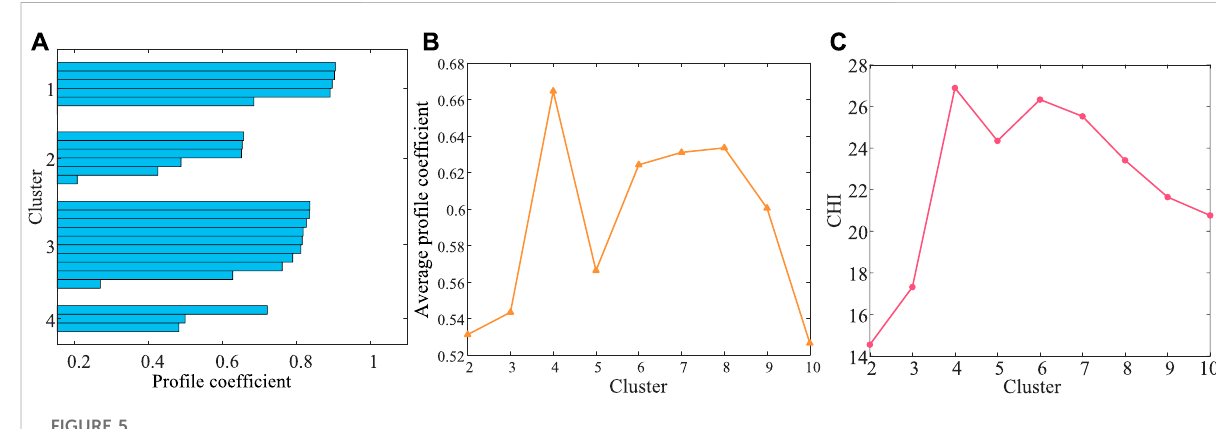
FIGURE 5 Clustering evaluation indexes. (A) Pro fi le coef fi cient; (B) Average pro fi le coef fi cient; (C) CHI.